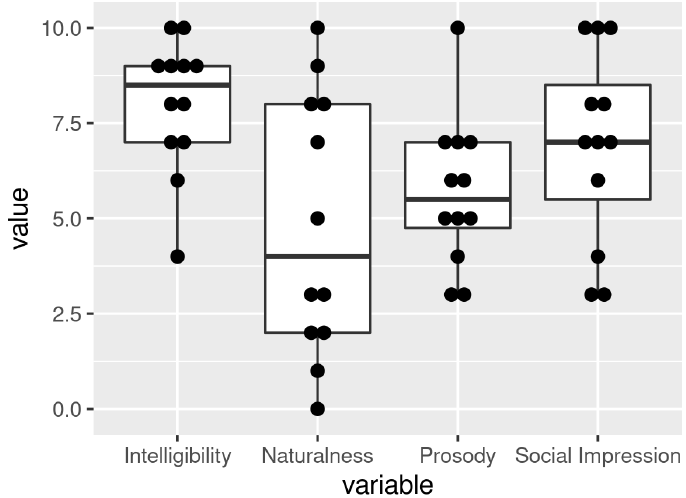
Figure 11. Subjective ratings of Pepper’s synthetic